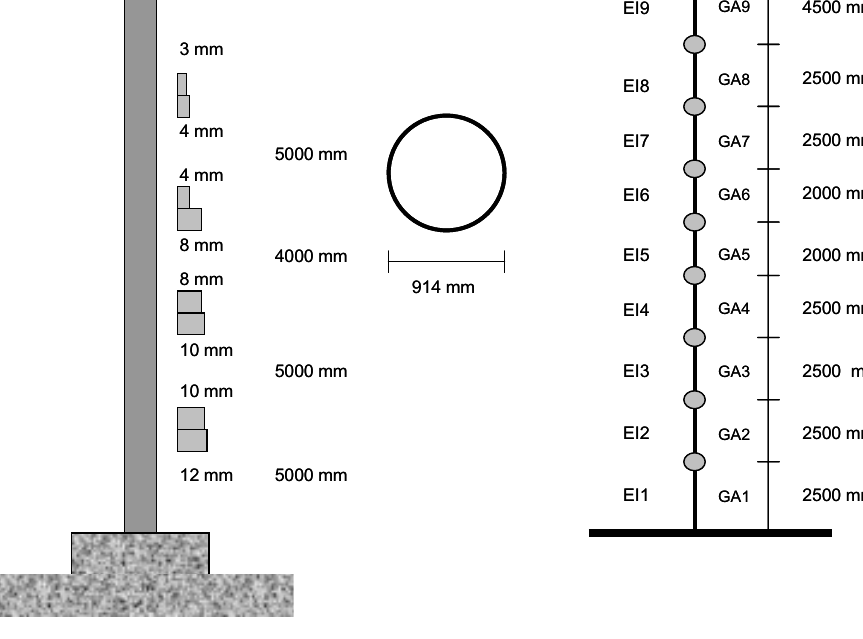
Fig. 2. A simulated steel chimney [21].